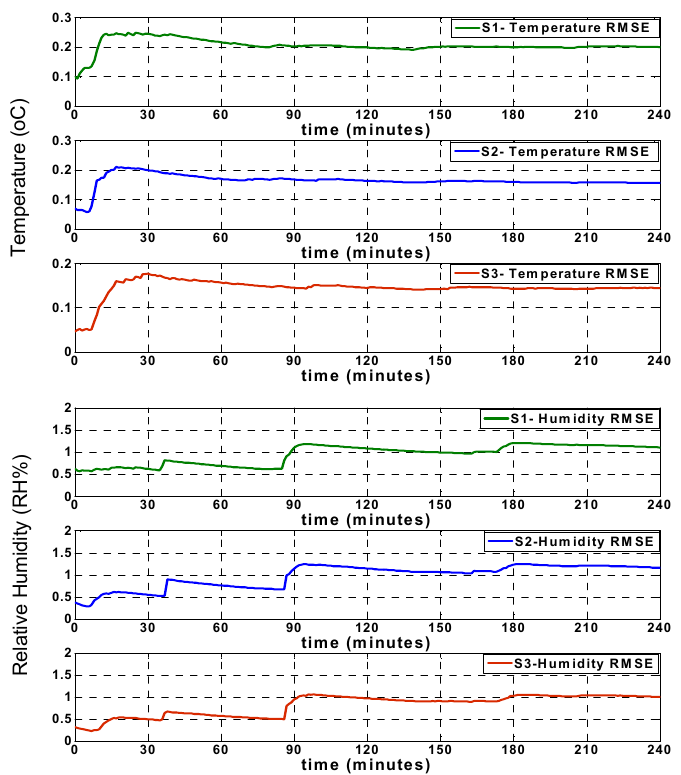
Figure 8. RMSE of ANN